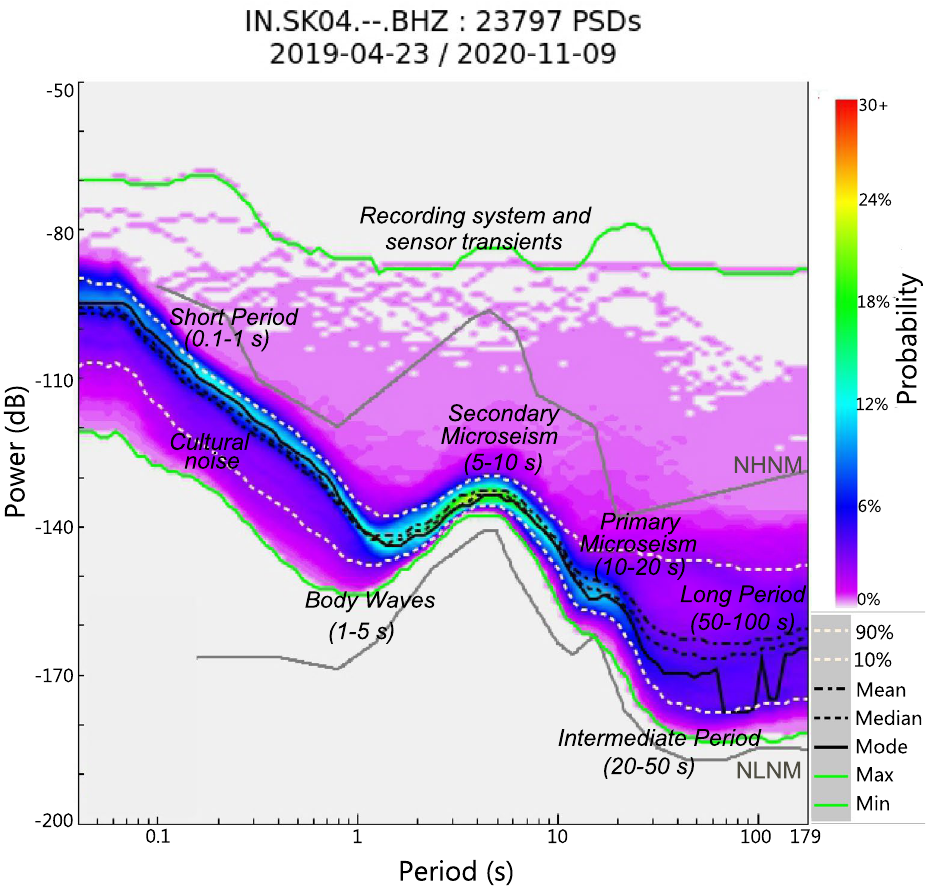
Figure 2. Power Spectral Density (PSD) plot of seismic background noise characteristics. The colour bar shows the probability of noise at each frequency. NHNM: New High Noise Model, NLNM: New Low Noise Model. White upper and lower dotted lines represent the 10th and 90th percentiles of the PSD, respectively. Black dashed, dotted and solid lines represent the mean, median and mode of the PSD respectively, while upper and lower solid green lines represent the maximum and minimum envelope of the PSD,